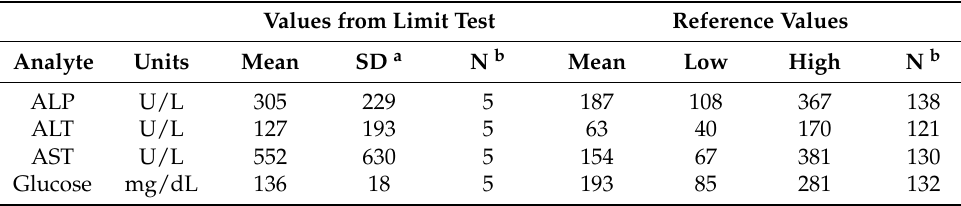
Table 1. Biochemical biomarkers levels of mice exposed to AgNPs during the limit test assay. Alkaline phosphatase (ALP), aspartate aminotransferase (AST), Alanine aminotransferase (ALT), and Glucose (Glu) concentrations were quantified and compared with reference values of BALB/c